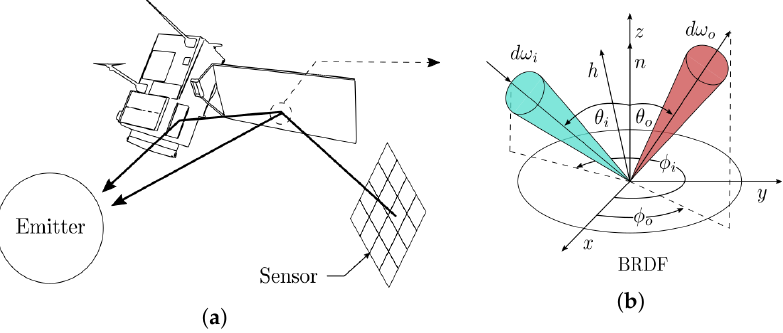
Figure 3. Backward ray tracing. ( a ) Ray integration. ( b ) Material